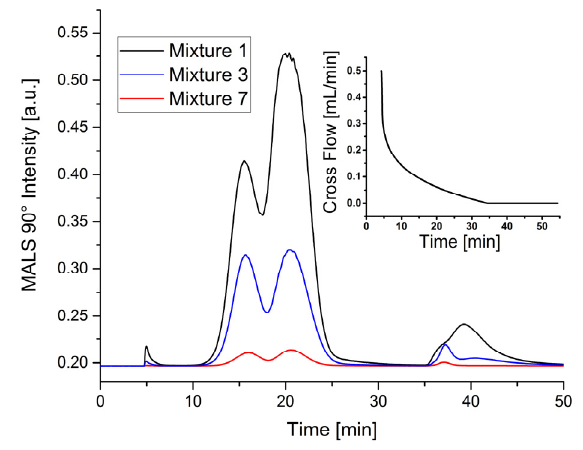
Figure 1. Fractograms of polystyrene nanoparticle mixtures (50, 100 and 400 nm) with three different particle concentrations (see Table 4) using the miniaturized channel. Insert shows cross flow profile, MALS 90° detector.